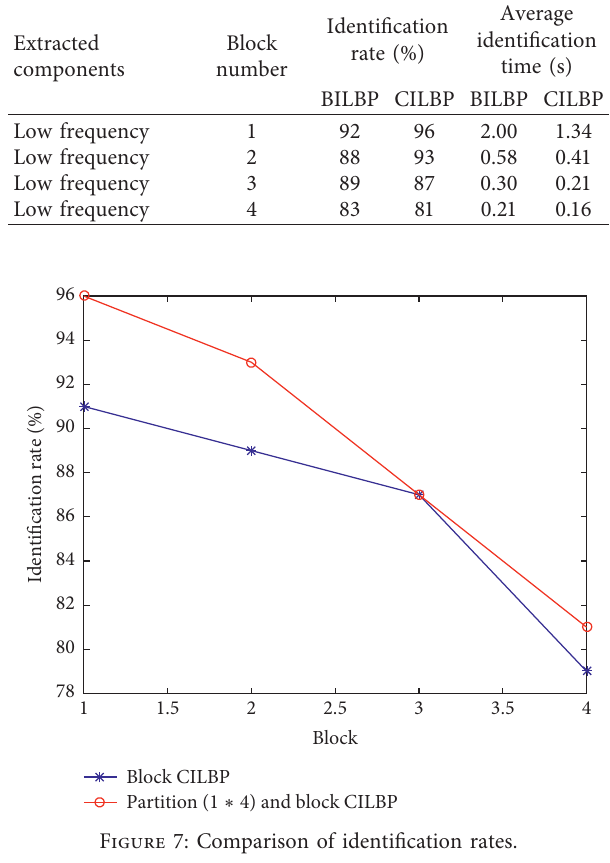
Figure 7: Comparison of identification rates.